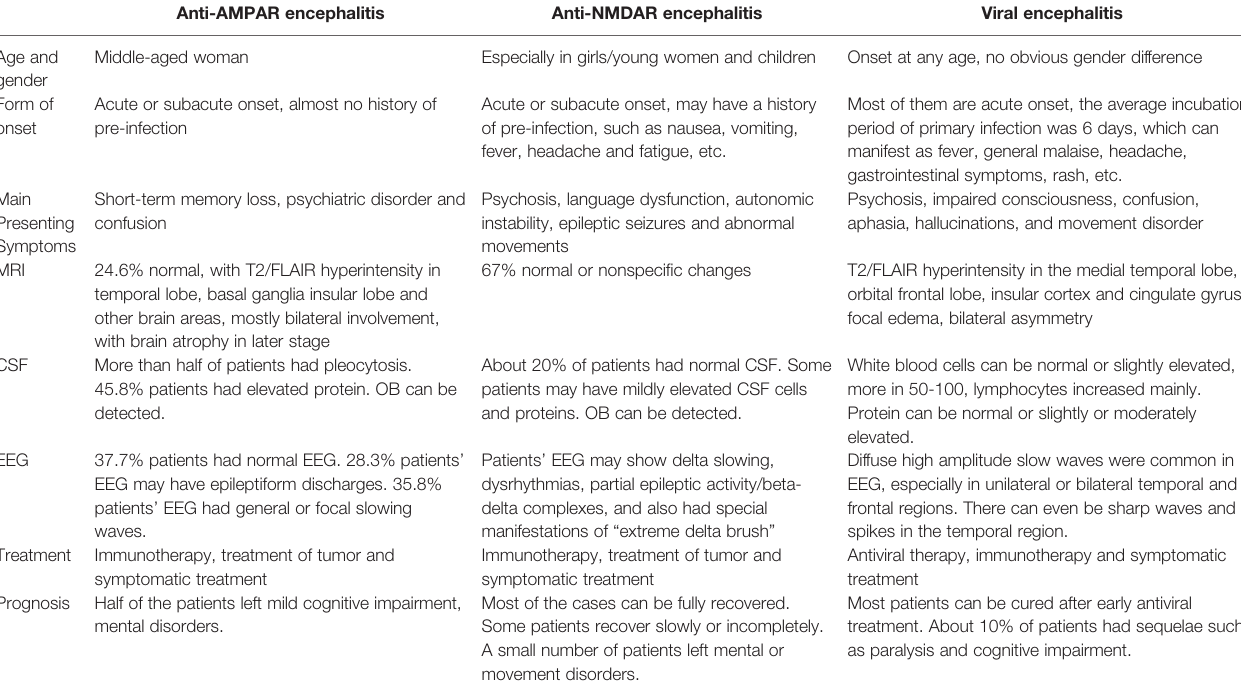
TABLE 5 | General features distinguishing anti-AMPAR encephalitis from important differential diagnoses (43, 45, 46). Anti-AMPAR